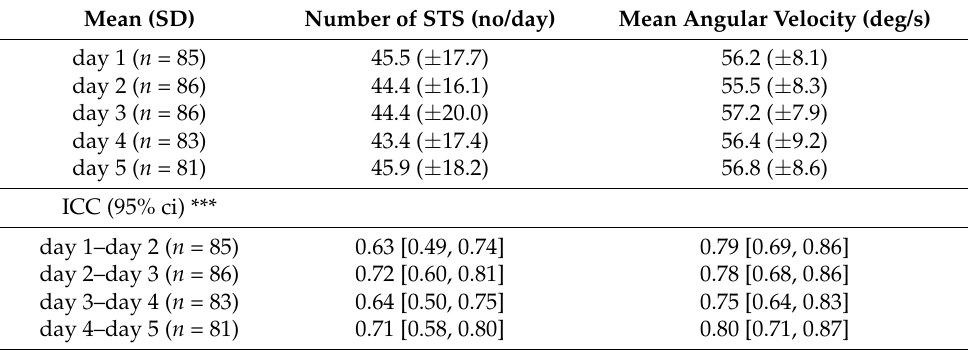
Table 3. Mean values of free-living STS variables for five follow-up recording days and intraclass correlation coefficients between four day-pairs ( n = 86).